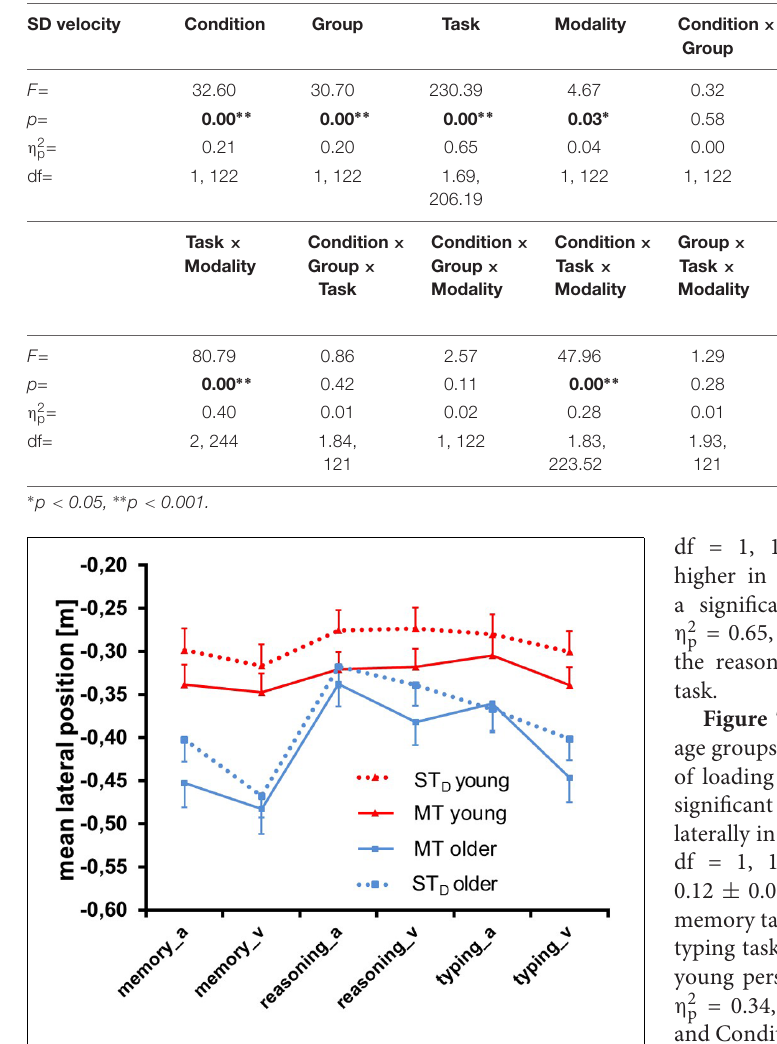
FIGURE 7 | Mean lateral position ± SE of both age groups in single task (ST D ) and multitask (MT) conditions. Memory, reasoning and typing task were presented auditorily (_a) and visually